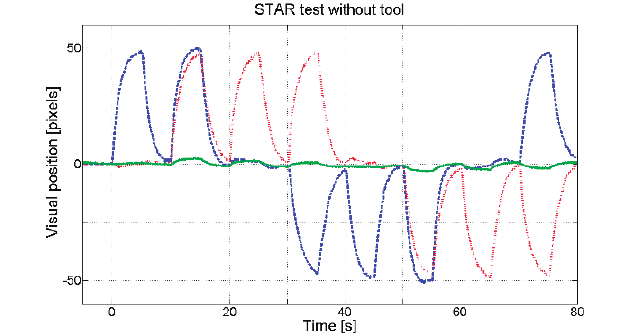
Figure 23. End-e(cid:636)ector visual position with respect to time during the STAR test performed without the tool. The three components of the task space vector x v are shown: u R (blue dashed line), v R (red dotted line) and u L − u R (green solid